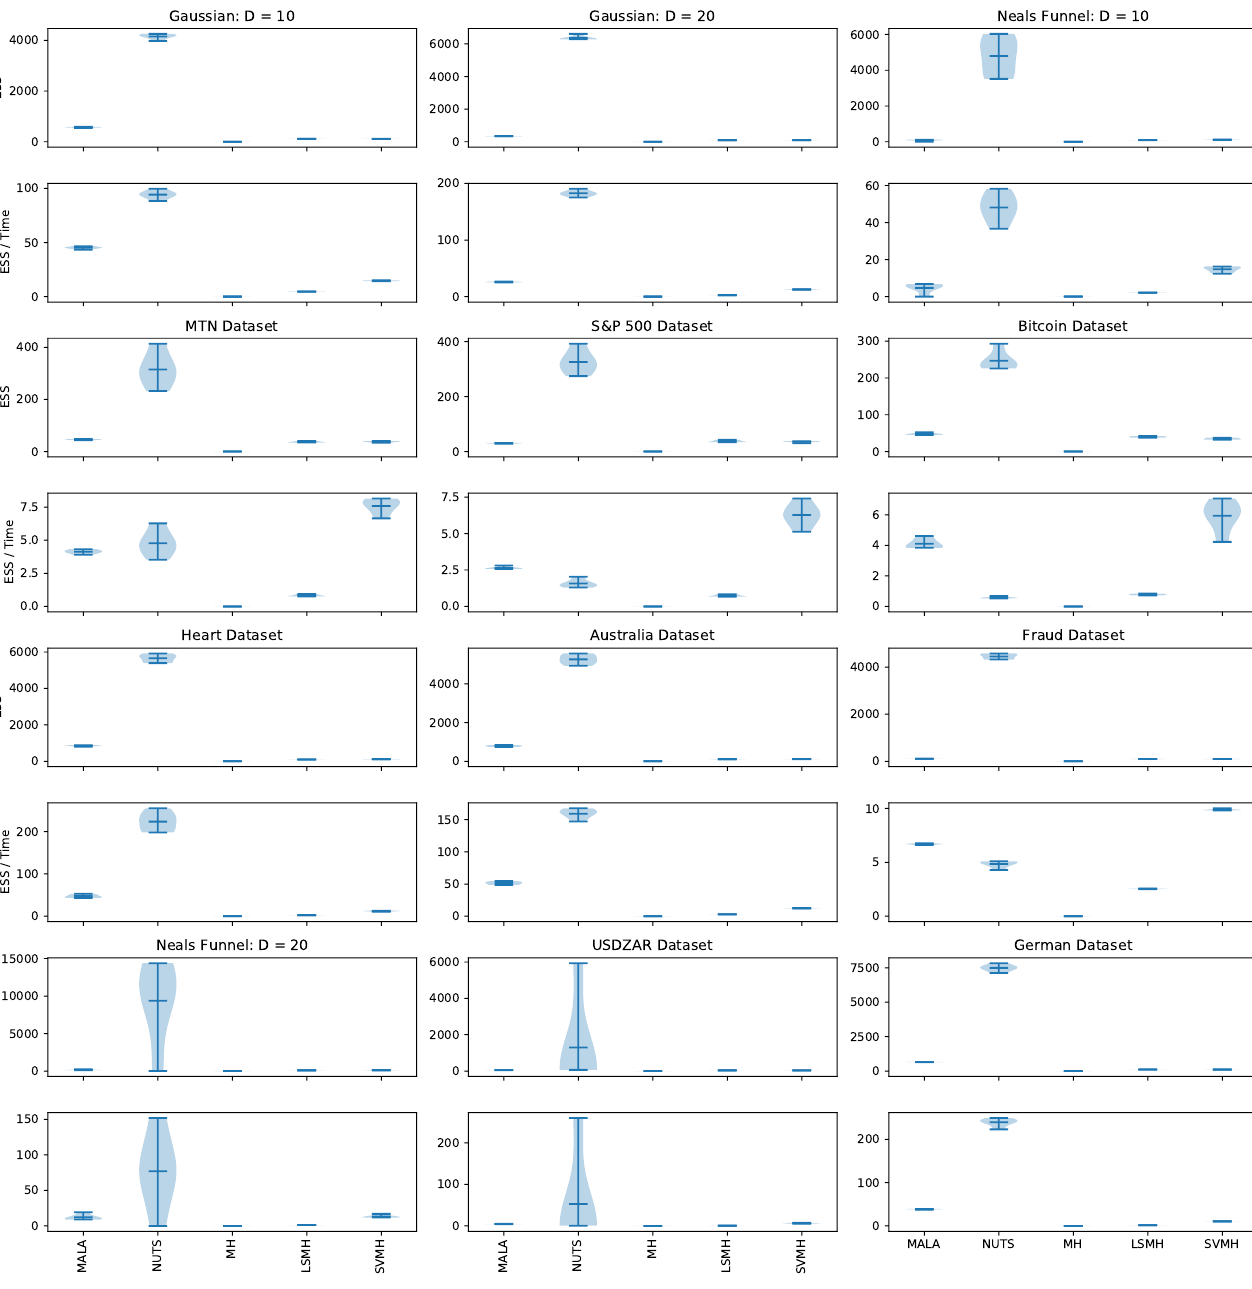
Figure 1. Inference results across each dataset over thirty iterations of each algorithm. The first row is the effective sample size while the second row is the time-normalised effective sample size for each